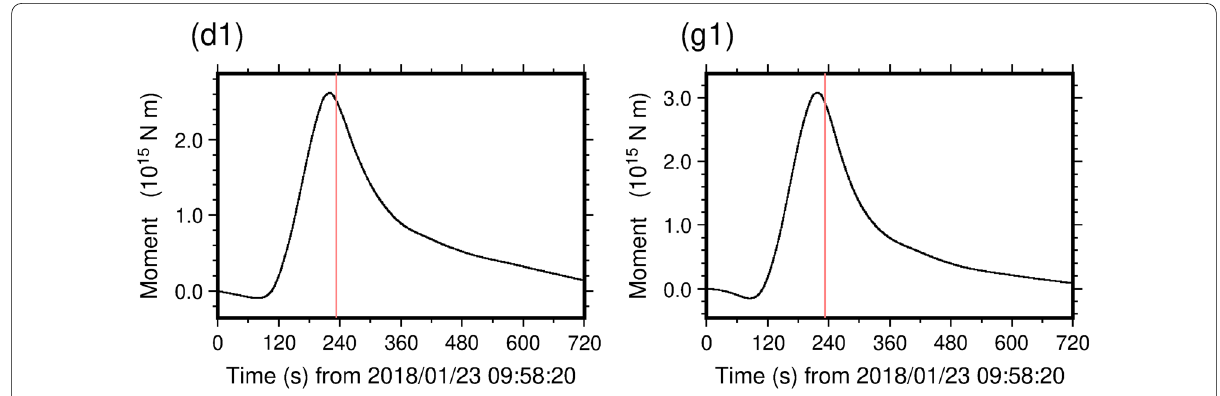
Fig. 14 Source time functions of candidates ( d1 ) and ( g1 ). The notation is the same as that used in Fig.